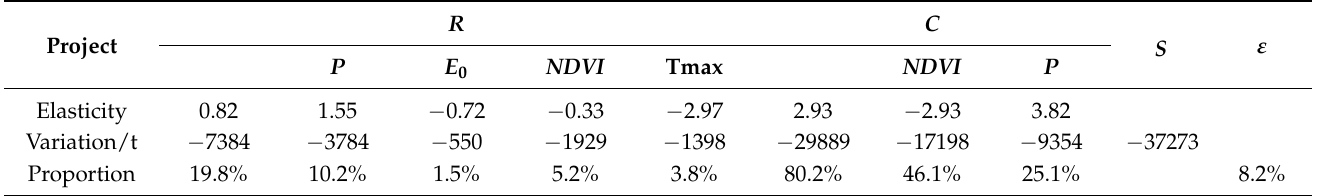
Table 5. Elasticity and significance of logarithmic function of climate change and ecological resto- ration on sediment concentration C. Table 6. Elasticity and change of sediment induced by climate change and ecological